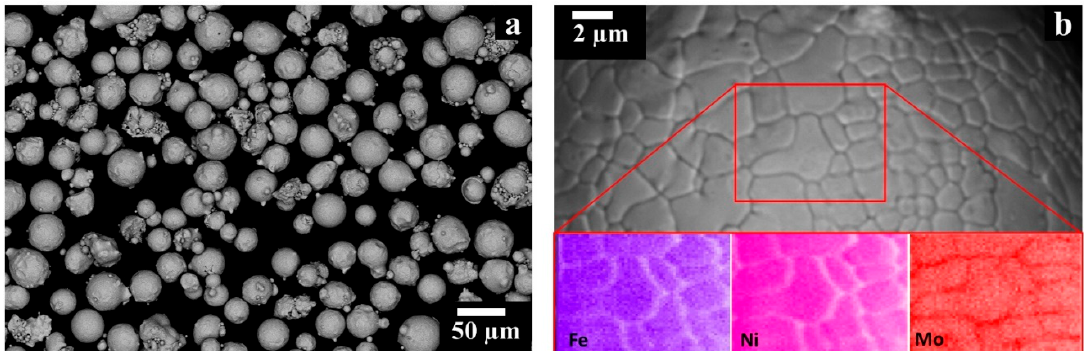
Figure 1. Backscattered electron (BSE) SEM images of Hastelloy X (HX) particles showing: ( a ) particle size and morphology; ( b ) dendritic microstructures of one particle with enrichment in Mo and depletion of Fe and Ni within the interdendritic areas.